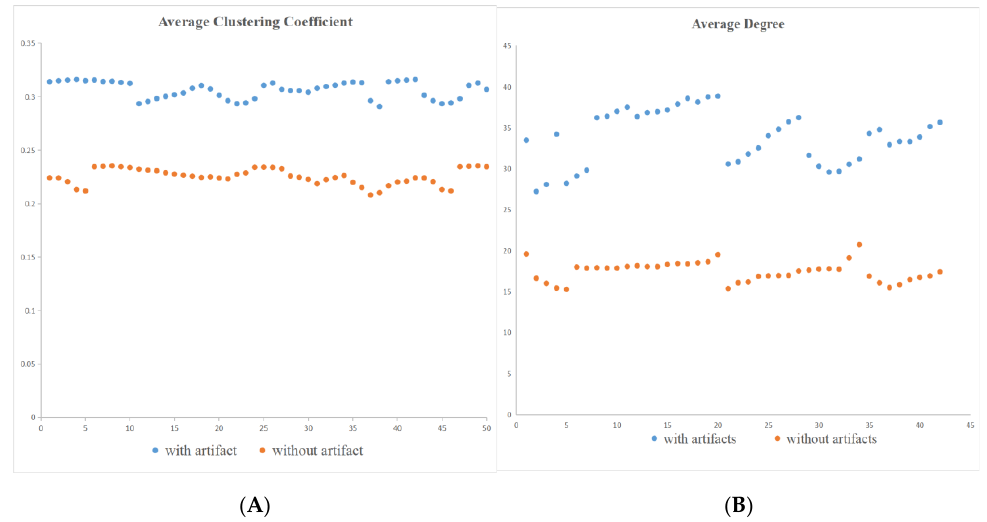
Figure 5. Different network topological properties from a part of data sets, ( A ) depicts the average clustering coefficient, ( B ) depicts average degree, respectively. It is worth noting that both the average clustering coefficient and the average degree of the CT images with artifacts are larger than those of the CT images without artifacts, respectively.